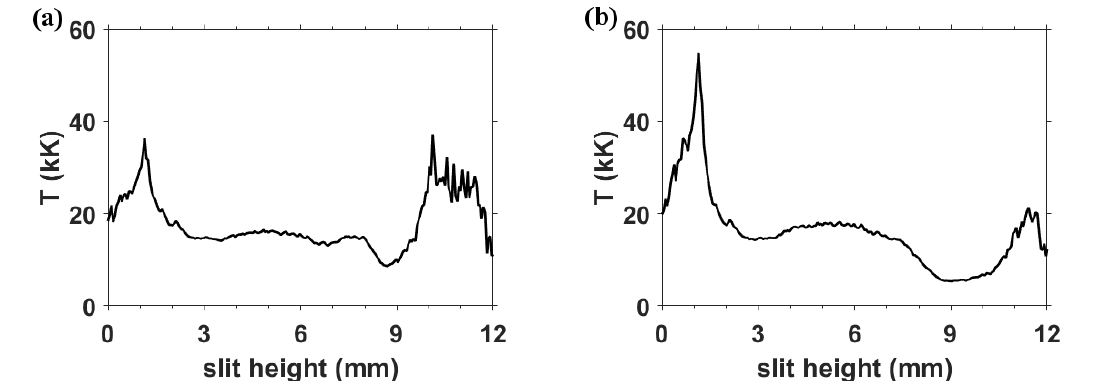
Figure 13. Electron temperature from line-of-sight data. ( a ) τ = 1.5 µ s, 0.025- µ s gate. Average temperature: 17.9 kK. ( b ) τ = 2.5 µ s, 0.025- µ s gate. Average temperature: 16.3